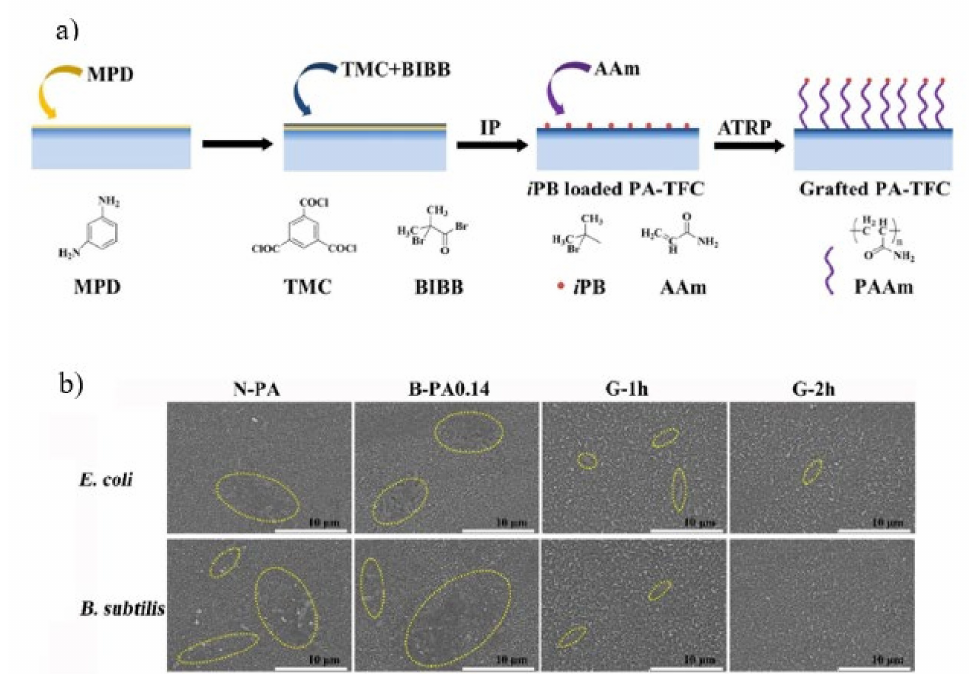
Figure 11. ( a ) Schematic illustration of membrane fabrication using PAAm by ATRP; ( b ) SEM images of N-PA, B-PA0.14, and grafted membranes after immersion in E. coli and B. subtilis suspensions for 24 h. The circles indicate the observed bacteria